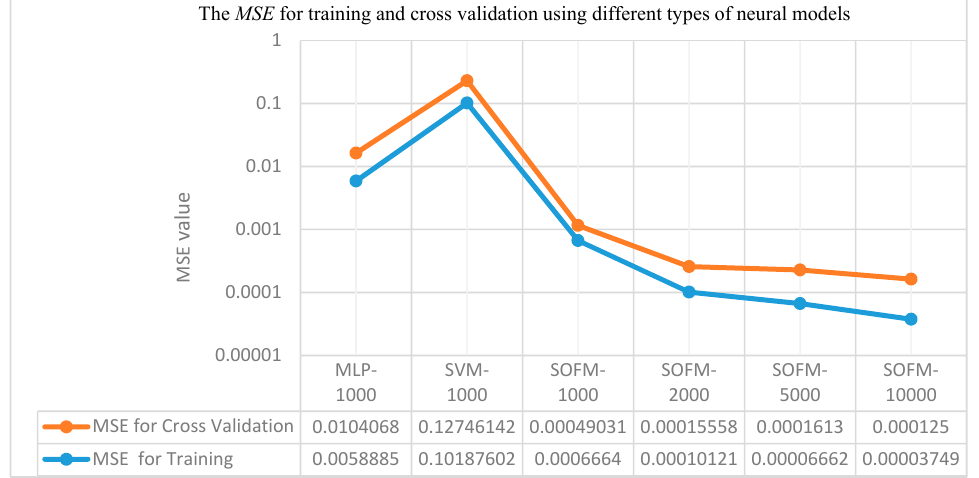
Figure 17. The comparison results of the final MSE for the multi-layer perceptron (MLP), support vector machine (SVM) and SOFM models.